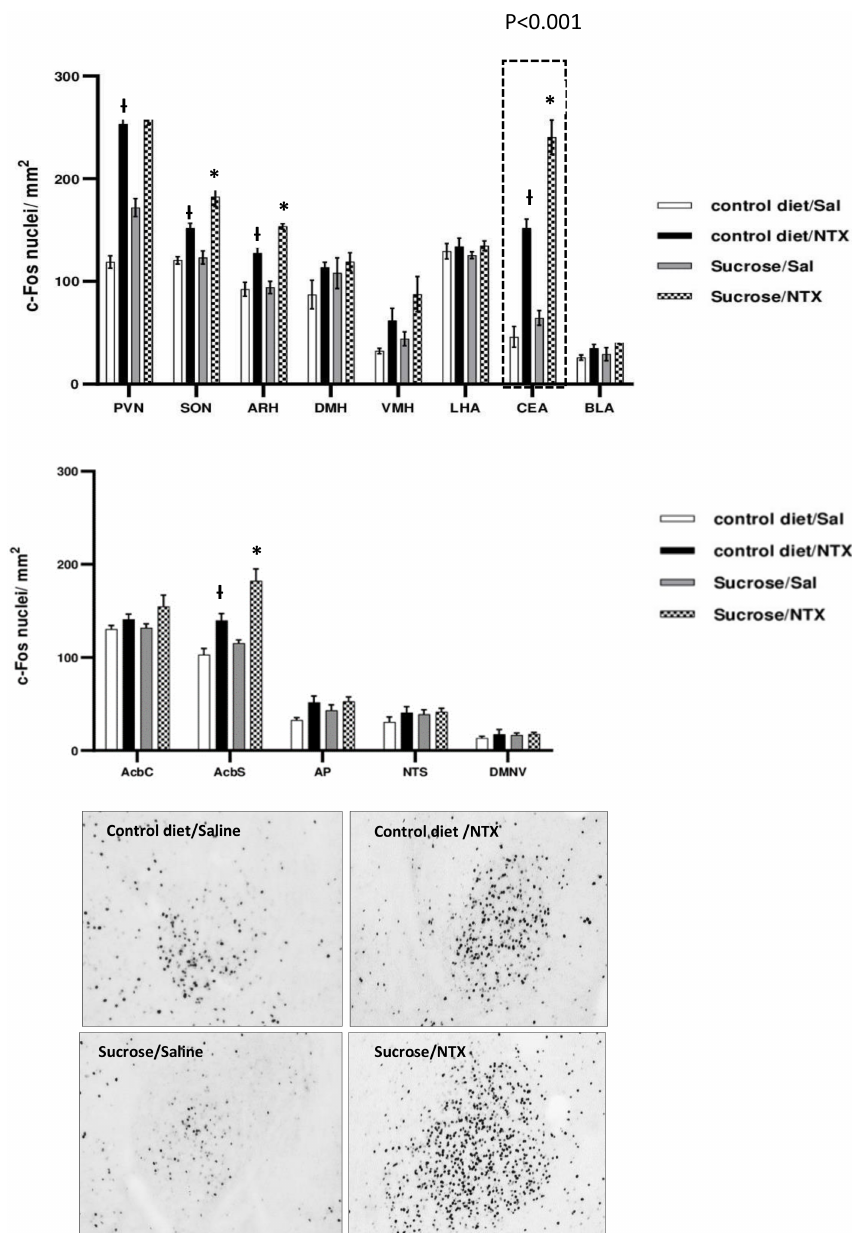
Figure 7. The effect of saline vs NTX (1 mg/kg) on c-Fos immunoreactivity in specific brain sites in control diet vs sucrose consuming rats. * Significantly different from control diet/NTX group. Ɨ Significantly different from control diet/saline group. The photomicrographs depict c-Fos immunoreactivity in the central nucleus of the amygdala of rats exposed to standard vs sucrose-enriched diet that received a saline or NTX injection. The CeA was the site where the highest level of drug x diet interaction of all regions examined in our study was noted.